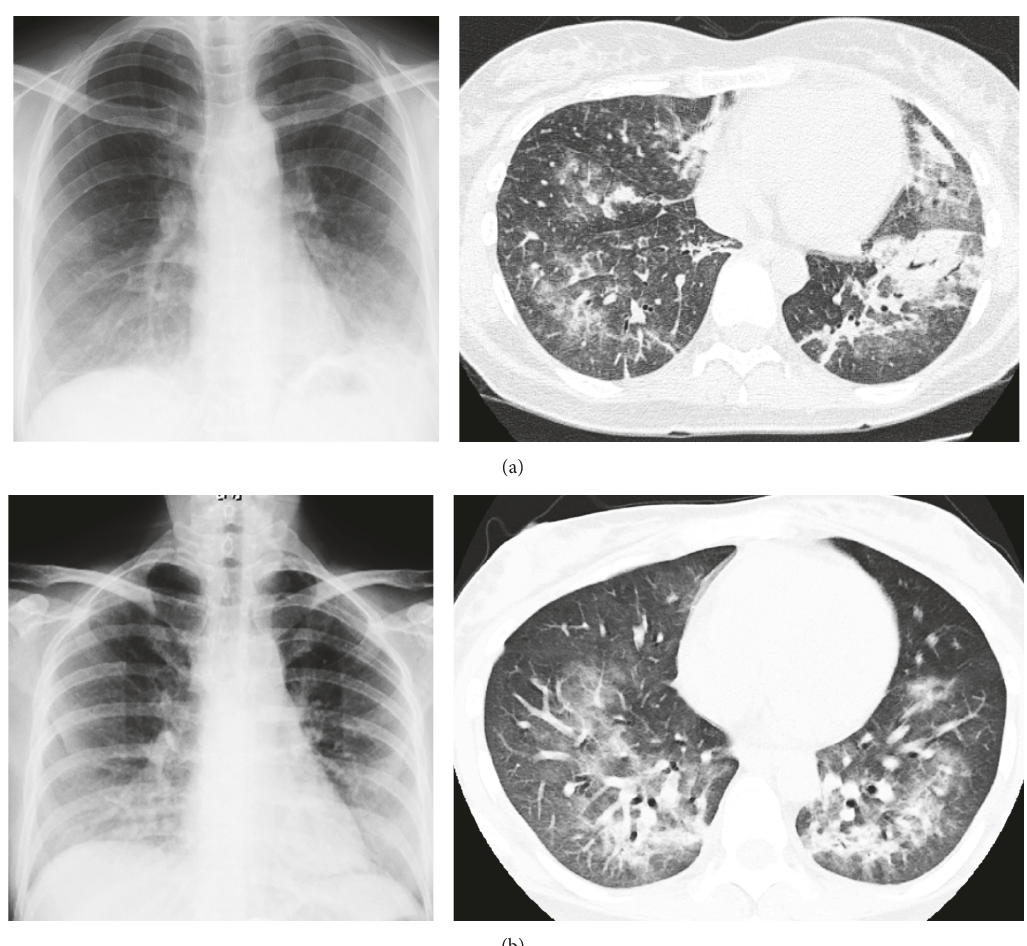
Figure 1: Chest X-ray (left) and computed tomography (CT) (right) images of case 1 (a) and case 2 (b). Chest X-ray showed a high density area in the lower lobes, which was detected as a diffuse ground-glass pattern on CT in both